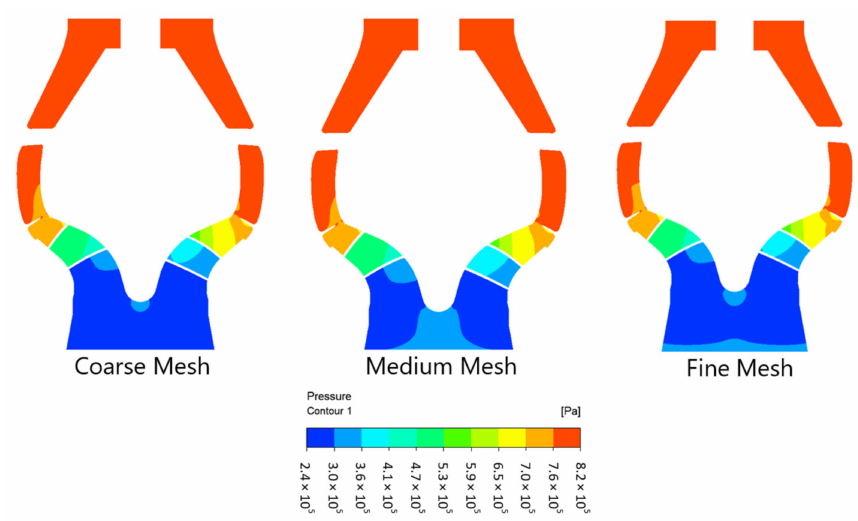
Figure 6. The pressure gradient across the pump assembly at 90% rated